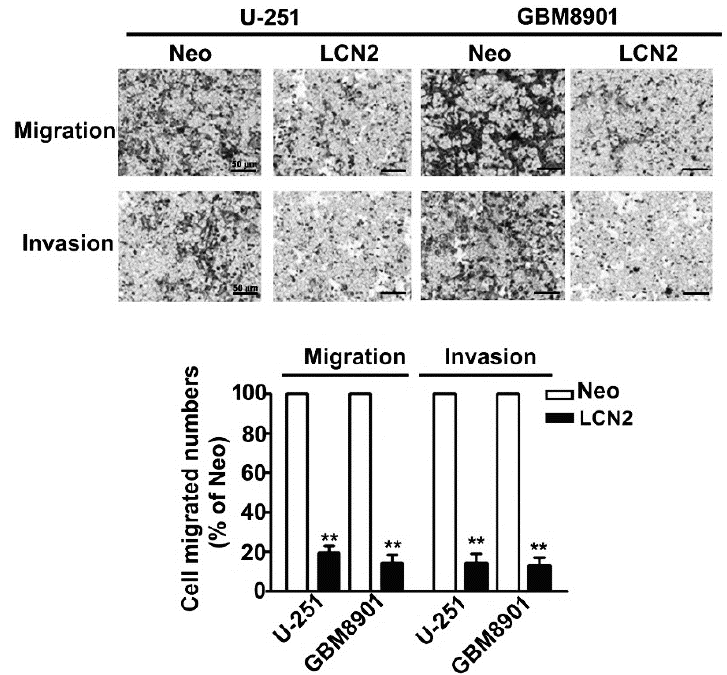
Figure 3. Migration and invasion of LCN2-overexpressing GBM cells. In vitro migration assay and Matrigel-invasion assay were used to assess the migration and invasion ability of LCN2-overexpressing cells. Cells in the lower surface of the Borden chamber were stained and photographed under a light microscope. The number of cells that migrated or invaded were counted, and the results are shown in the histogram in the lower panel. Data are presented as the mean ± SE of at least three independent experiments. ** p < 0.01 compared with Neo-expressing cells. Scale bar = 50 μ m.